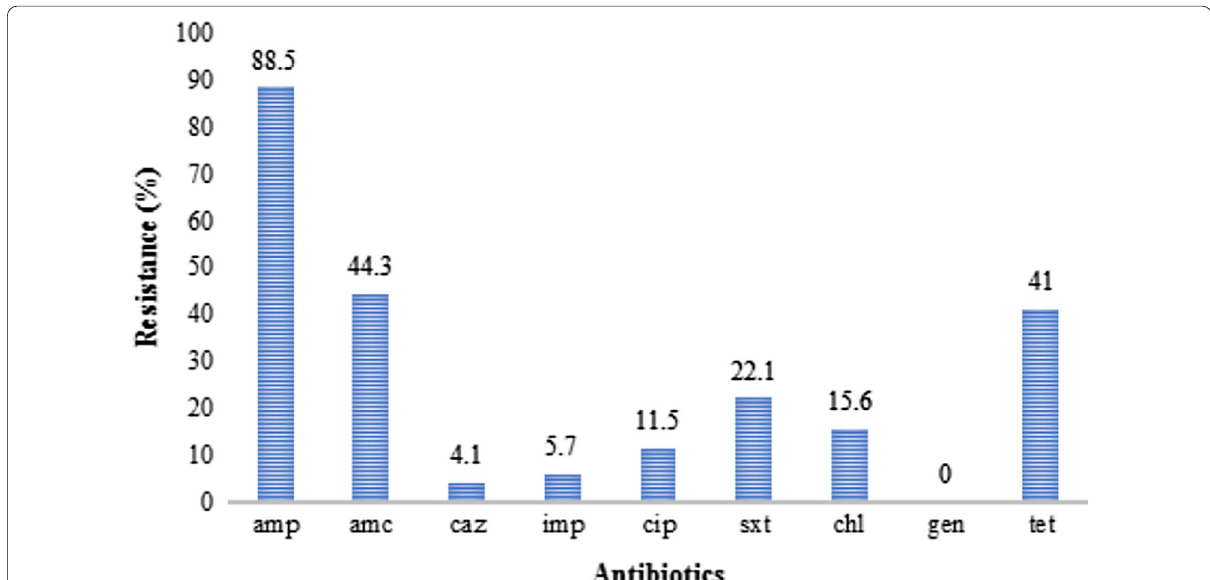
Fig. 2 Resistance of the Vibrio spp. to selected antibiotics. KEY: amp: ampicillin; amc: amoxicillin-clavulanate; caz: ceftazidime; imp: imipenem; cip: ciprofloxacin; sxt: trimethoprim-sulfamethoxazole; chl: chloramphenicol; gen: gentamicin; tet: tetracycline